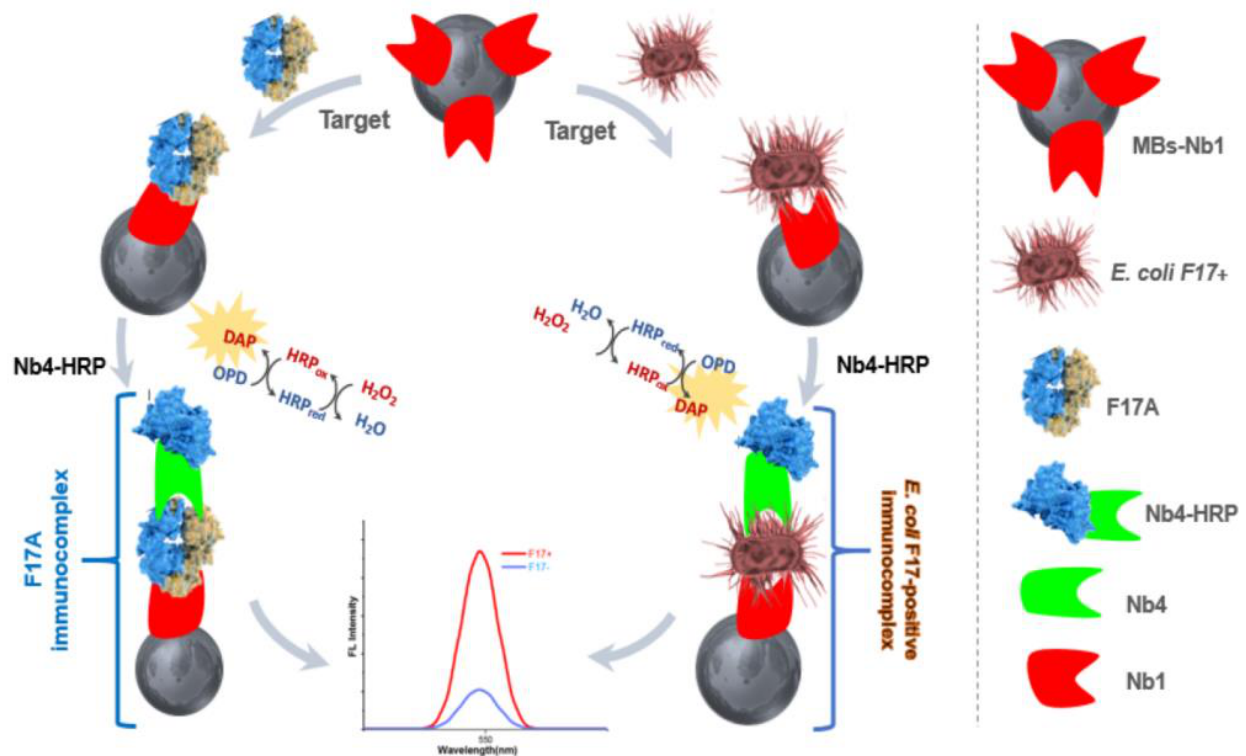
Scheme 1. Illustration of the development of the fluorescent bioplatform for the detection of the F17A protein and E. coli F17